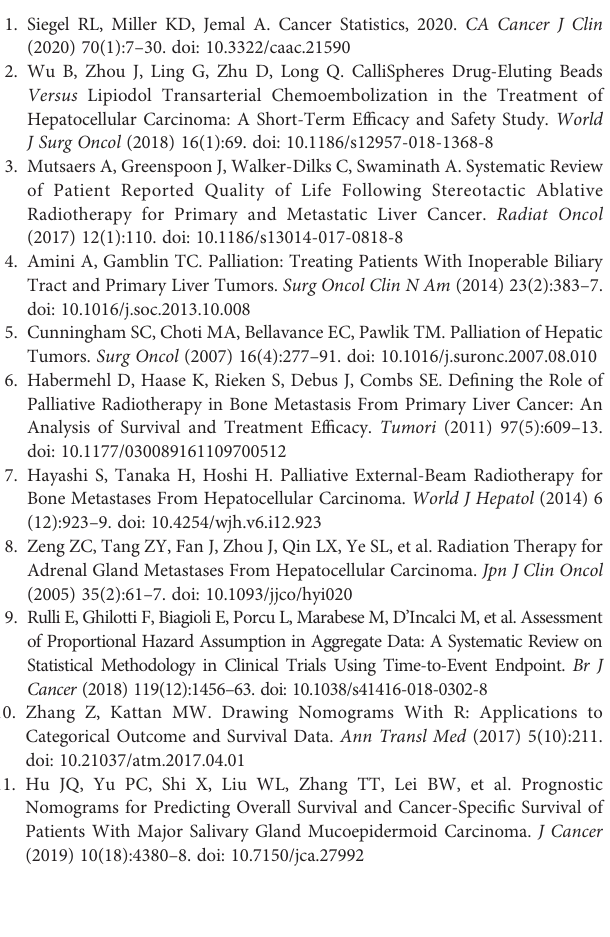
Supplementary Figure 1 | Kaplan-Meier curve of overall survival of included patients. Supplementary Figure 2 | Calibration curves of the 1- (A) and 2-year (B) OS of the predictive model in training phase. Supplementary Figure 3 | Calibration curves of the 1- (A) and 2-year (B) OS of the predictive model in validation phase. Supplementary Figure 4 | Kaplan-Meier curves of overall survival of patients treated with SBRT or conventional